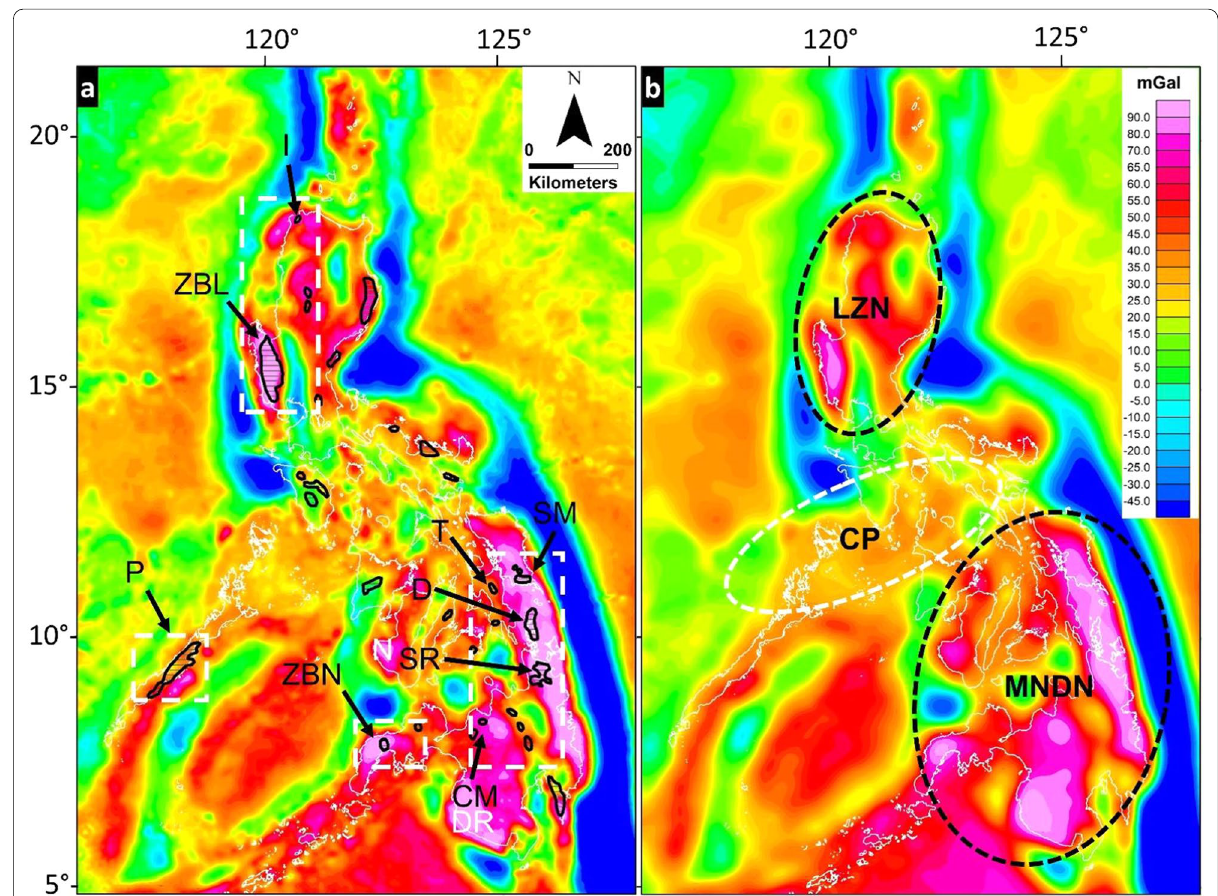
ophiolitic outcrops coincide with very high-gravity anomaly signatures (> 90mGal). Representative ophiolites and ophiolite complexes are labeled on the map: I Ilocos Norte Ophiolite, ZBL Zambales Ophiolite Complex, P Palawan Ophiolite, ZBN Zamboanga Ophiolite, T Tacloban = = = = = Ophiolite Complex, SM Samar Ophiolite, D Dinagat Ophiolite, SR Samar Ophiolite, CM Central Mindanao Ophiolite. White labels represent = = = = the massive magmatic arcs: N Negros, DR Daguma Range. White dashed polygons present the four major zones (> 90 mGal) that suggest = = thicker and more massive ophiolitic basement rocks. b Generally, the central Philippines has lower-gravity anomalies (20–35 mGal) than the rest